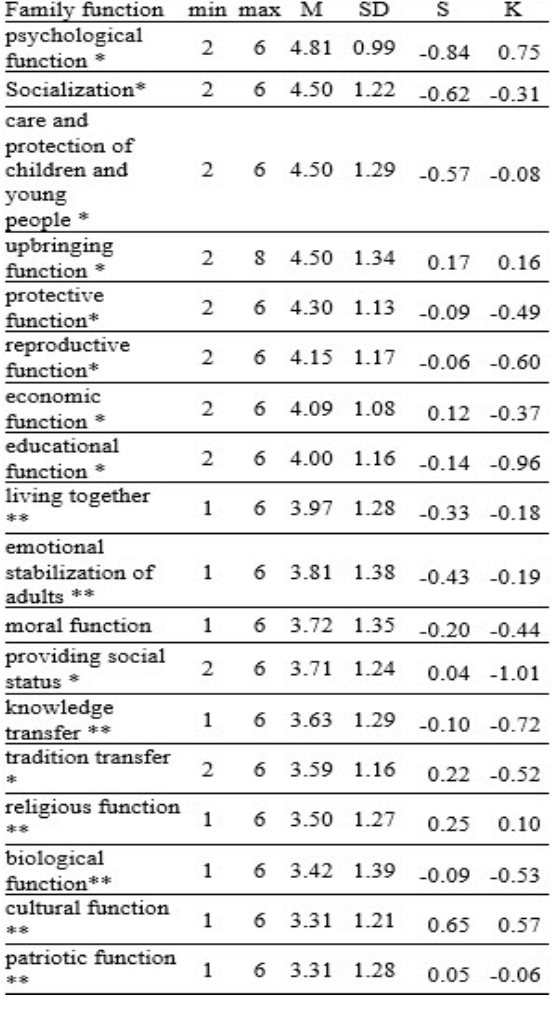
Table 1. The estimation of significance of family functions (for the whole